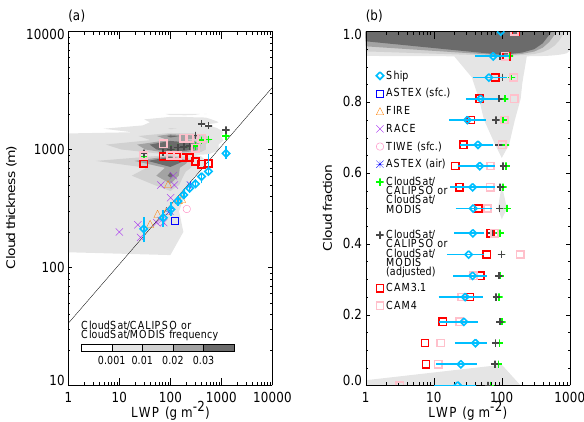
Fig. 2. (a) Median cloud thickness for LWP bins of varying size from the 2001-2007 Stratus cruises (with the interquartile ranges indicated by the vertical lines), CloudSat/CALIPSO (with and without precipitation removed), CAM3.1, and CAM4 along with values derived from various other field experiments [ASTEX (surface and aircraft), FIRE, RACE, and TIWE]. Also shown is the frequency distribution of CloudSat LWP/CALIPSO thickness data pairs. The thin line is the fit to Eq. (1). (b) Median LWP for cloud fraction bins of varying size from the Stratus cruises (with the interquartile ranges indicated by the horizontal lines), CloudSat/MODIS (with and without precipitation removed), CAM3.1, and CAM4.